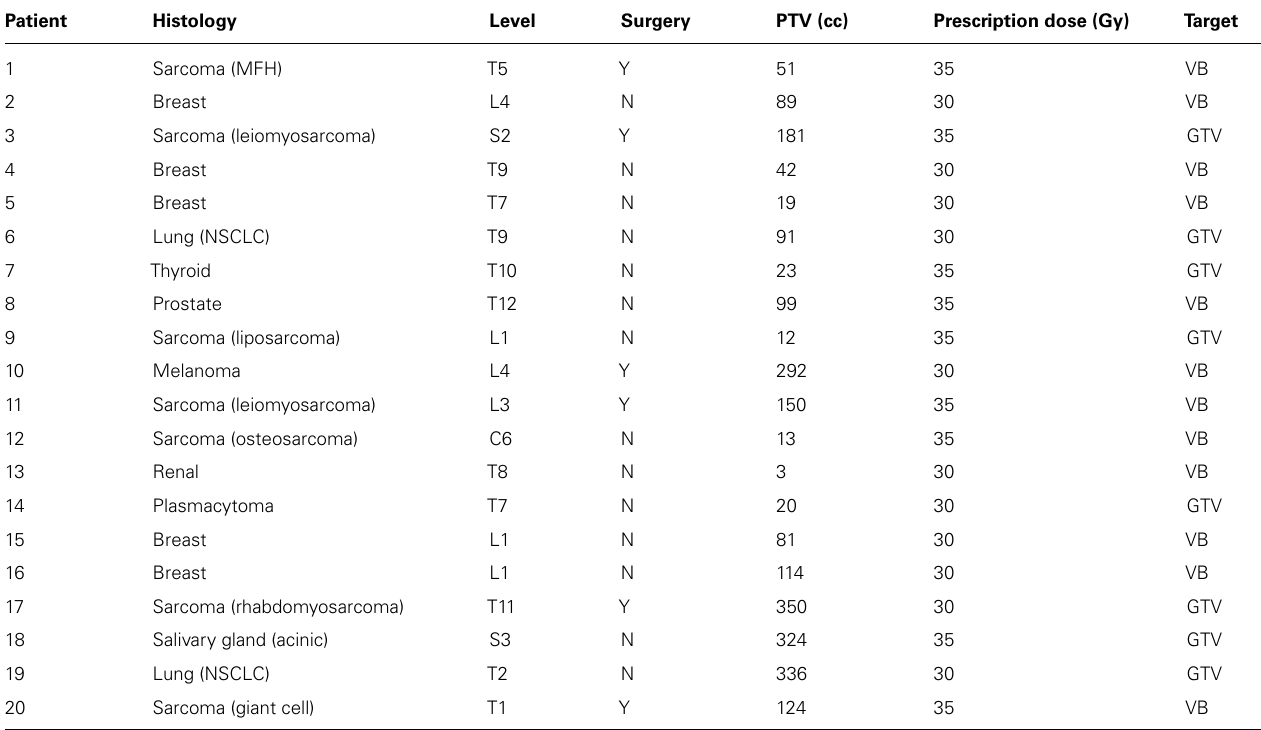
Table 2 | Treatment characteristics.